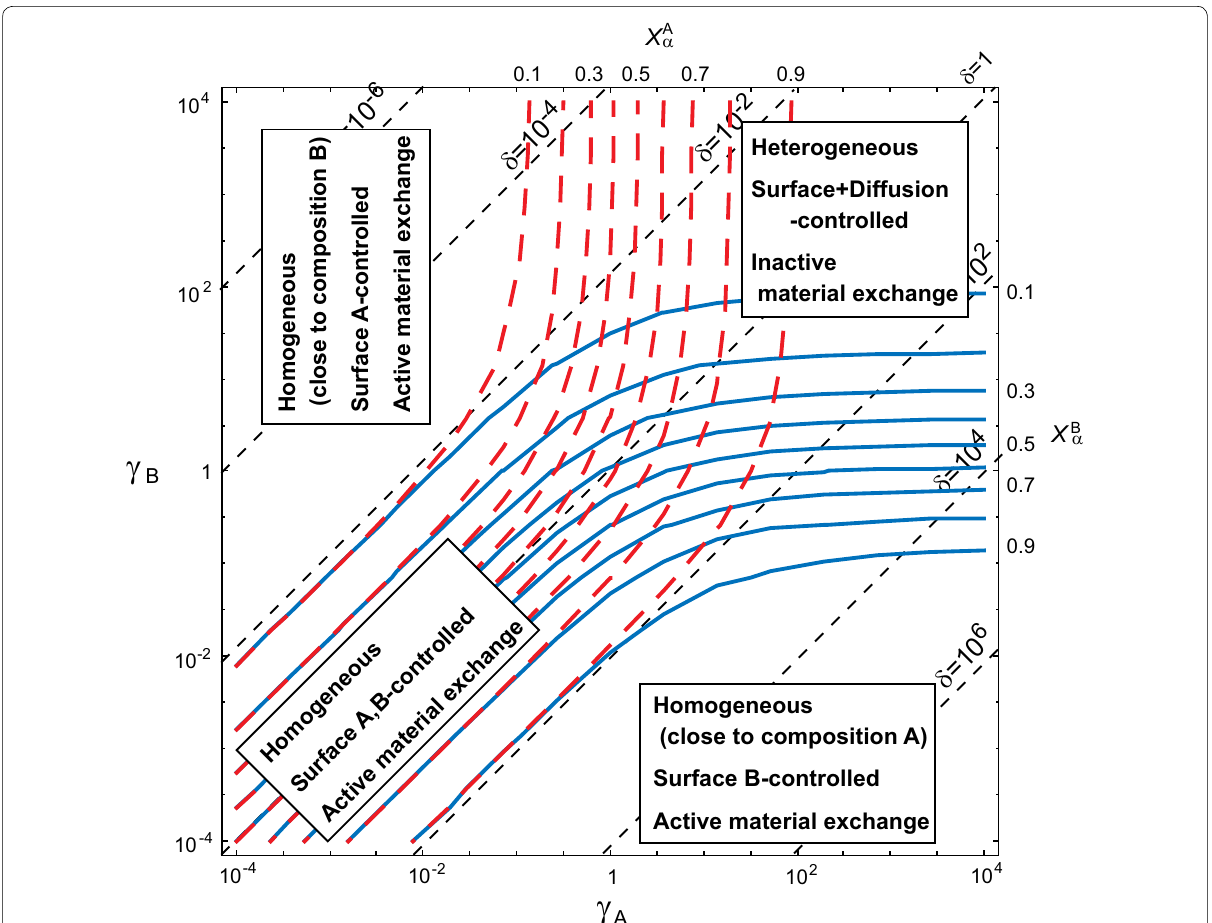
Fig. 2 A reaction mechanism map denoting the reaction mechanisms and the behavior of the system as a function of two dimensionless γ B space in which different behaviors can be observed. The contours of X A α (red lines) parameters, γ A and γ B . The map marks the regions in the γ A − and X B α (blue lines) are also presented. The broken lines are the contours of the dimensionless parameter δ that represent the ratio of k A to k